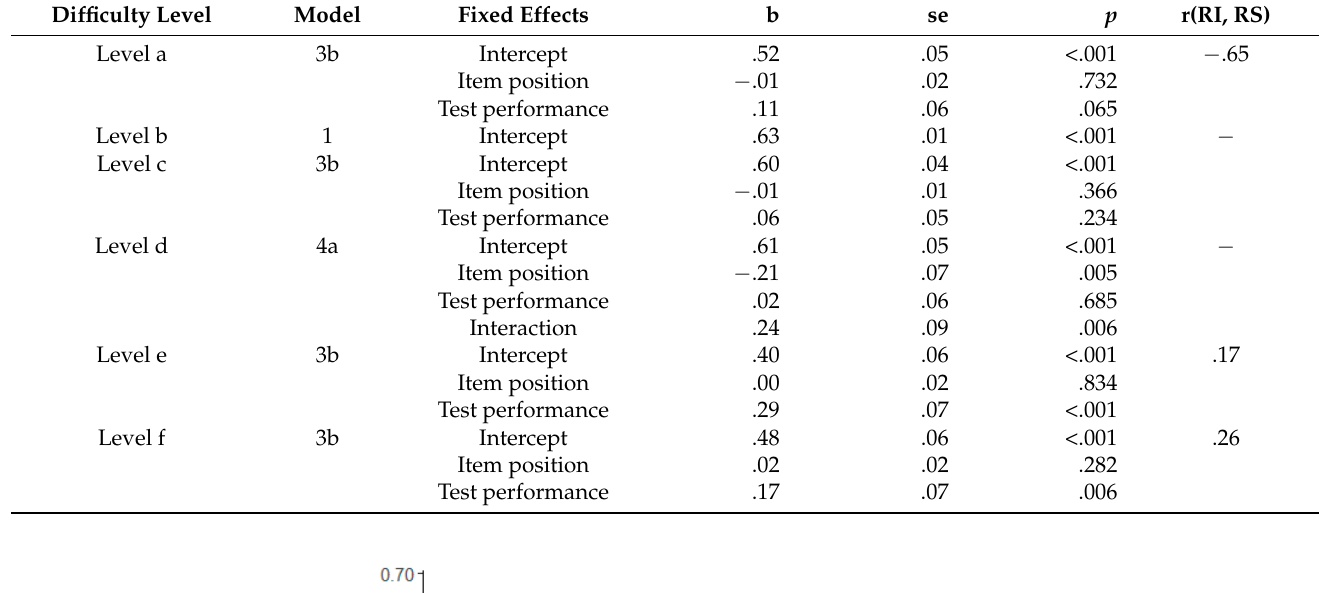
Table 8. Fixed effects and correlations between random intercept (RI) and random slope (RS) of the MLM with the dependent variable Levenshtein distance ratio.